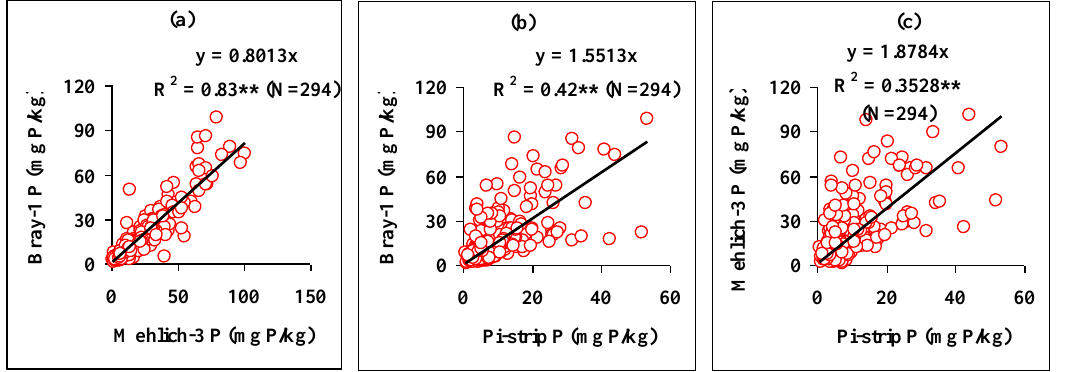
FIGURE 2. A comparison of the three soil test P methods; (a) B1 vs. Meh3, (b) B1 vs. strip, and (c) Meh3 vs. strip.